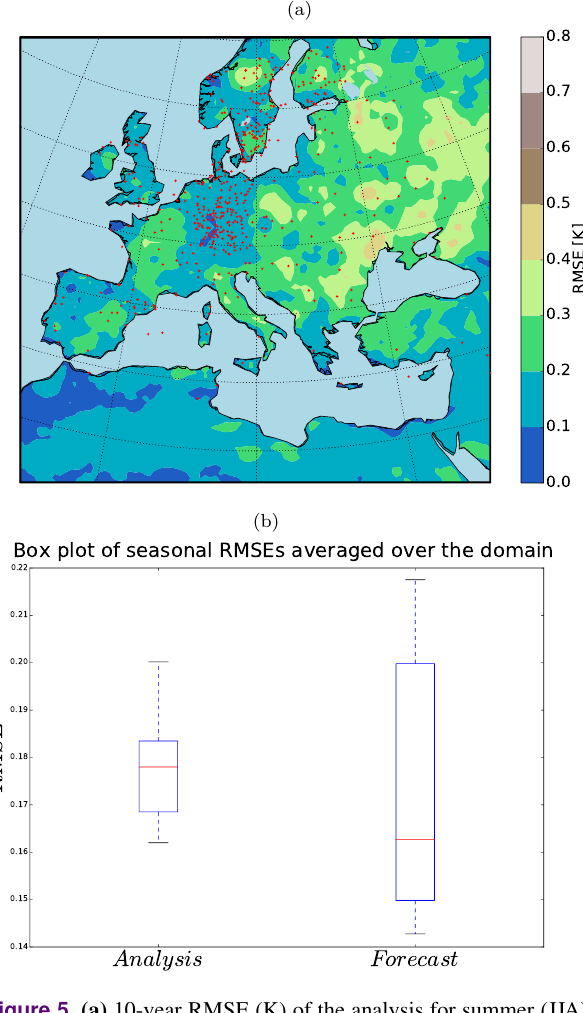
Figure 5. (a) 10-year RMSE (K) of the analysis for summer (JJA) and (b) the field mean RMSE (K) of the analysis and the free en- semble run for summer (JJA).